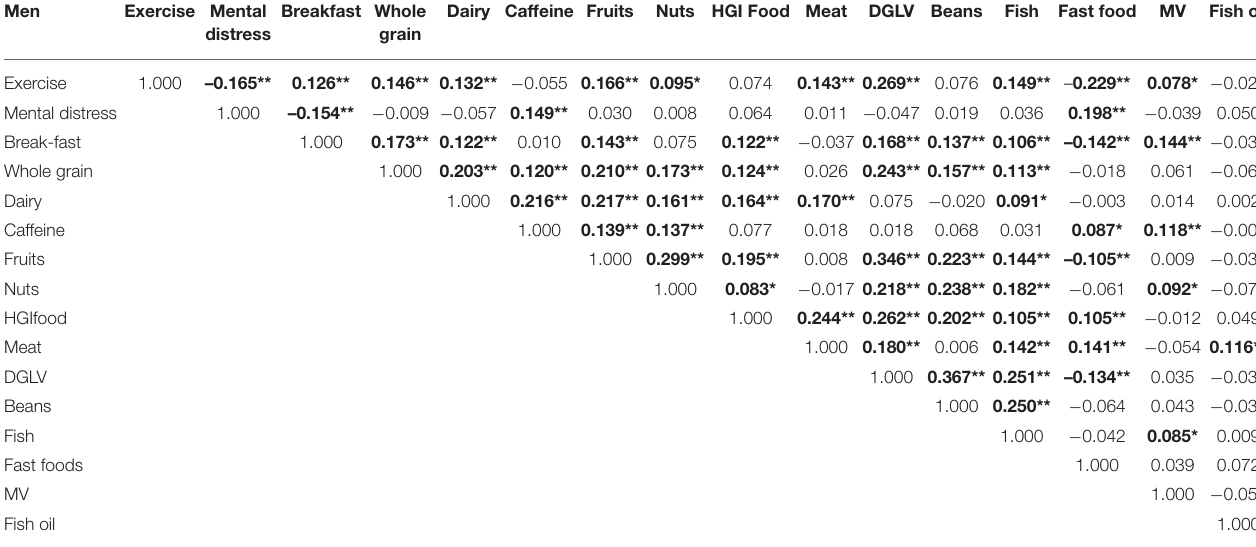
TABLE 5 | Spearman’s rho correlational analysis results for men. Men